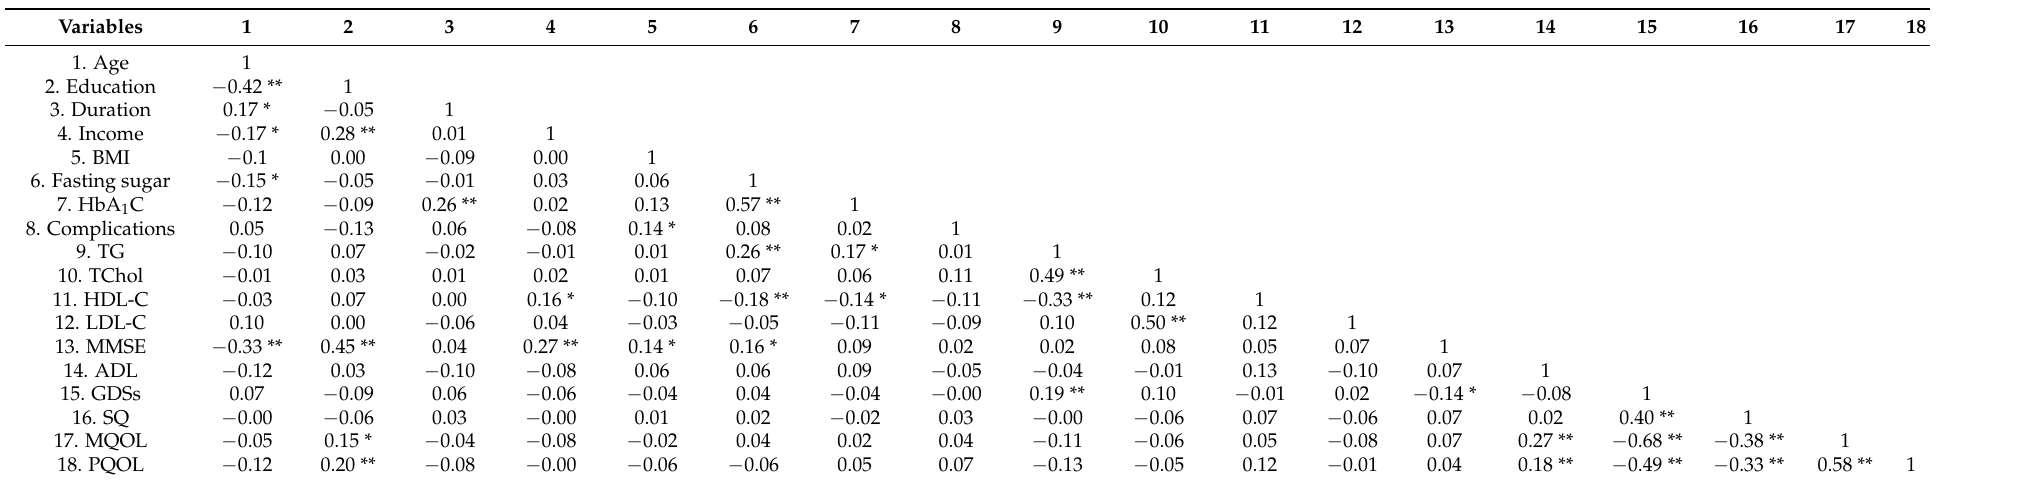
Table 2. Correlations among independent variables, depressive symptoms, and quality of